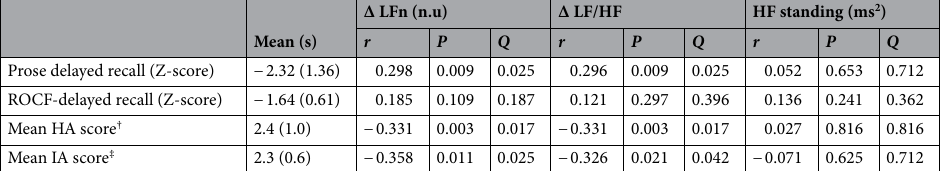
Table 5. Correlations of HRV indices with memory tests and brain atrophy in the aMCI group. Spearman’s correlation analysis adjusted for hypertension, physical activity and trait anxiety. Correlations with memory scores also demographically-adjusted. Cognitive Z-scores and visual rating scale scores expressed as mean (standard deviation). HRV, heart rate variability; aMCI, amnestic mild cognitive impairment; CT, computed tomography; MRI, magnetic resonance imaging; LFn, low frequency power (normalised); n.u, normalised units; LF/HF, ratio of low frequency power (LF) to high frequency power (HF); Δ HRV index, standing HRV index—baseline HRV index; ROCF, Rey-Osterrieth complex figure; HA, hippocampal atrophy; IA, insular atrophy. s , standard deviation; r , Spearman’s correlation coefficient; P , adjusted P -value; Q , adjusted P -value corrected for multiple testing with the Benjamini–Hochberg procedure with a 5% False Discovery Rate (FDR). †On CT. ‡ On MRI.